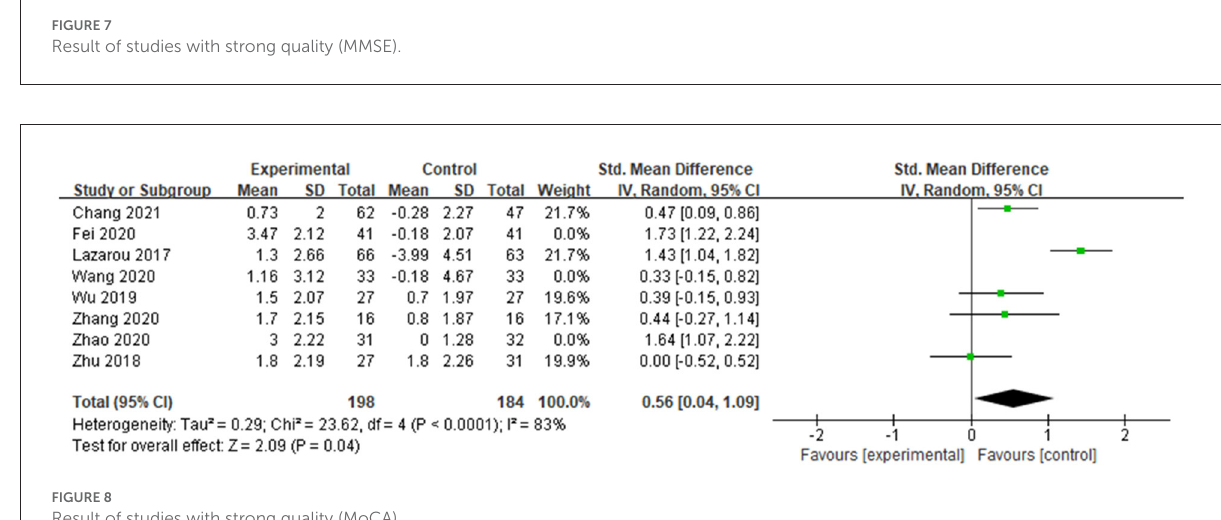
FIGURE7 Result of studies with strong quality (MMSE).